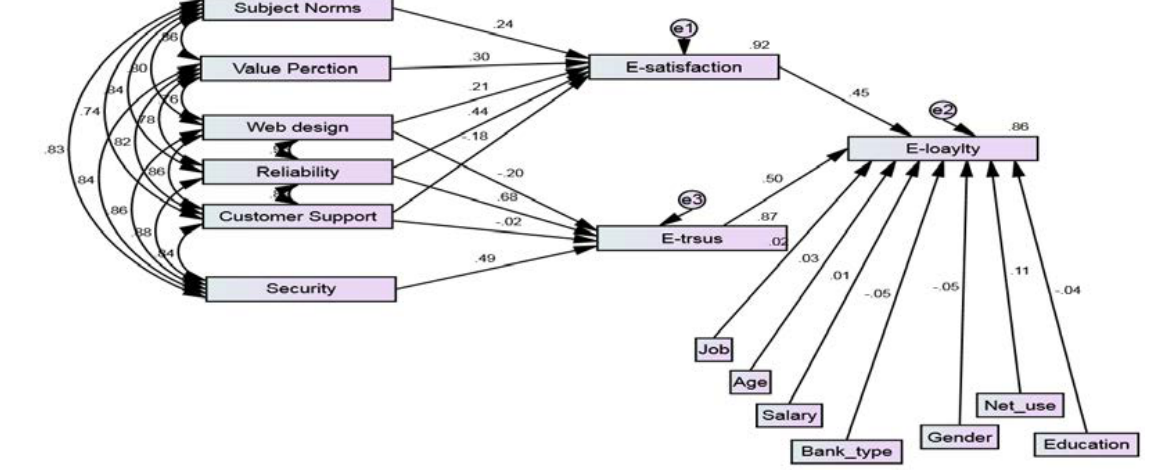
Fig. 3: Structural Equation Model of research construct Table 6: Maximum Likelihood Estimates